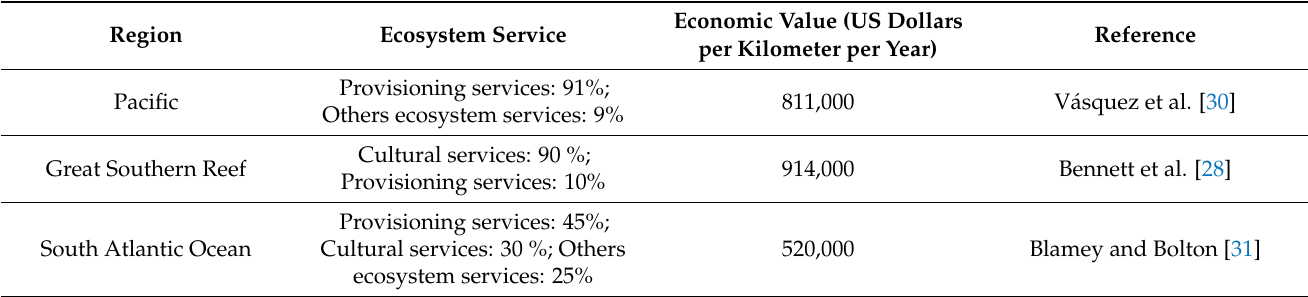
Table 3. Economic analysis of kelp forests ecosystem